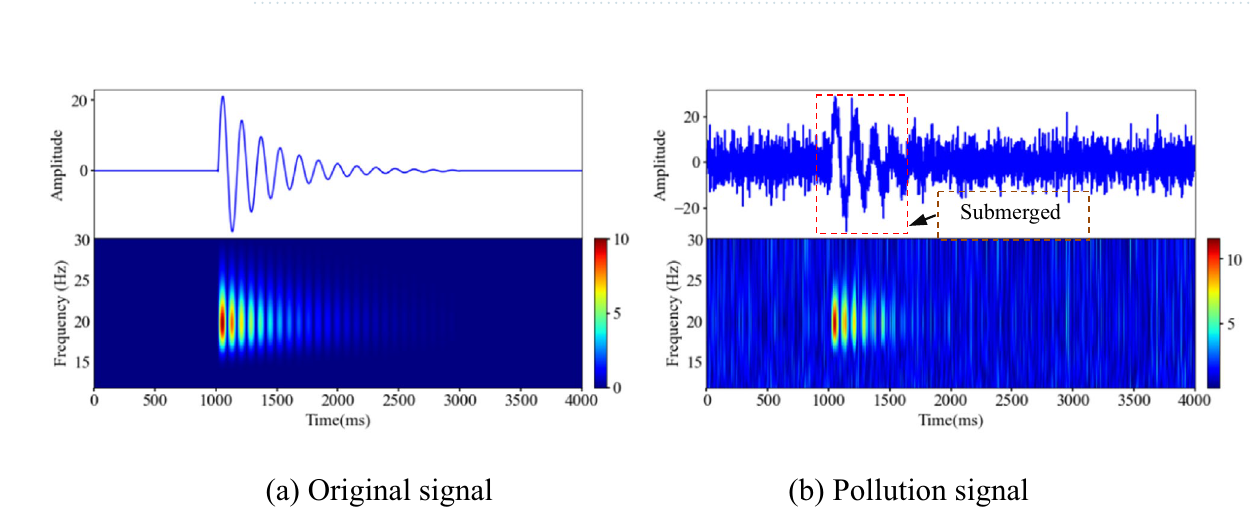
Figure 12. Characteristic description of the microseismic simulation signal and polluted signal (Spyder(Python3.6)). ( a ) Original signal ( b ) Polluted signal.